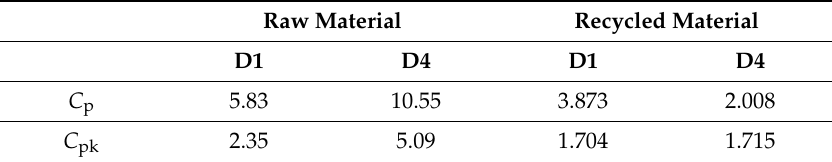
Table 4. C p and C pk for both